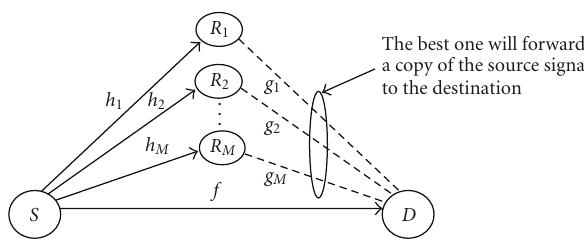
Figure 1: Illustration of the cooperative diversity network with the best-relay selection